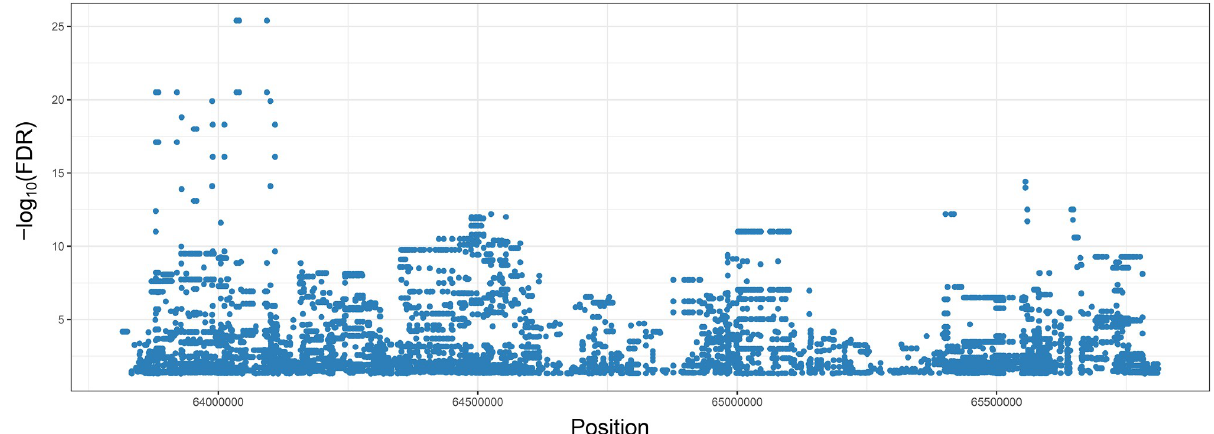
Fig 1. Regional scatter plot of the cis -mQTL results for the selected genomic region under analysis (chr11:63814813–65814813). Representation of the 6,958 cis -mQTLs identified in the genomic region previously associated to the disease. The x-axis corresponds to the genomic position of the SNP from each mQTL interaction; the y-axis refers to the transformed False Discovery Rate (FDR) of each signal.